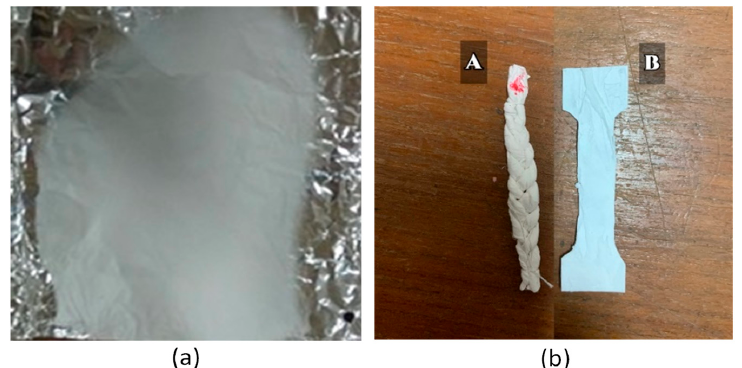
ester groups [15]. The C-O groups in PCL and the O-H hydroxyl groups in PLA serve as a marker for the interaction between the PLA and PCL molecules [16].